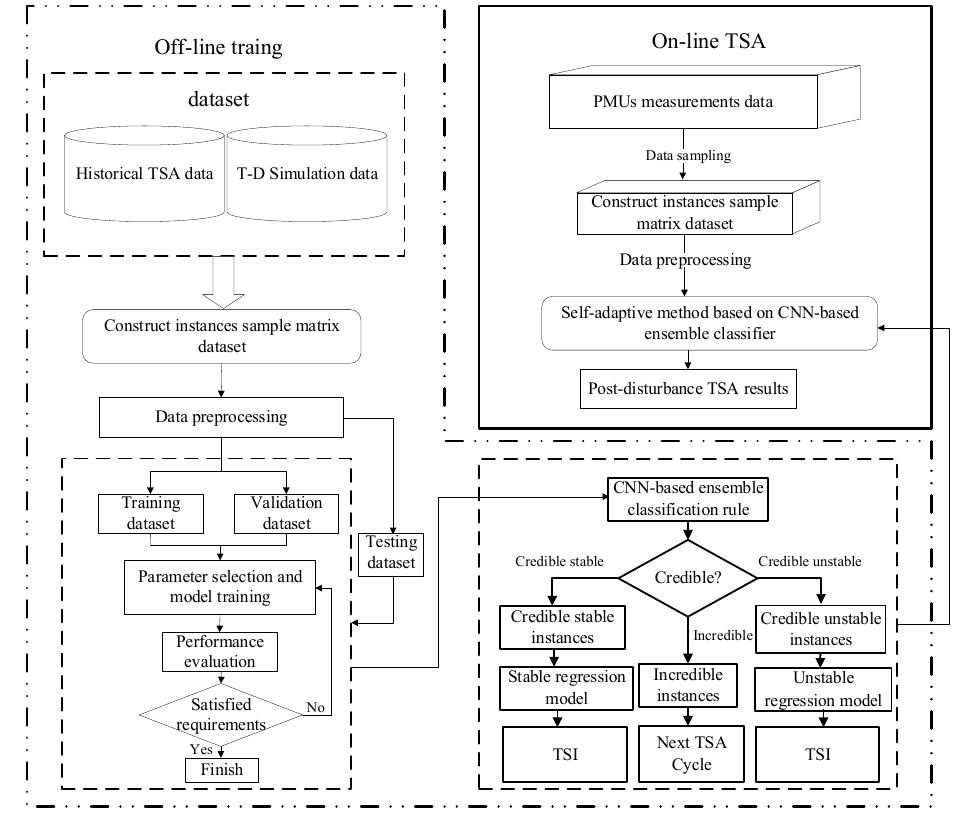
Figure A2. The process of off-line training and on-line application of proposed method.